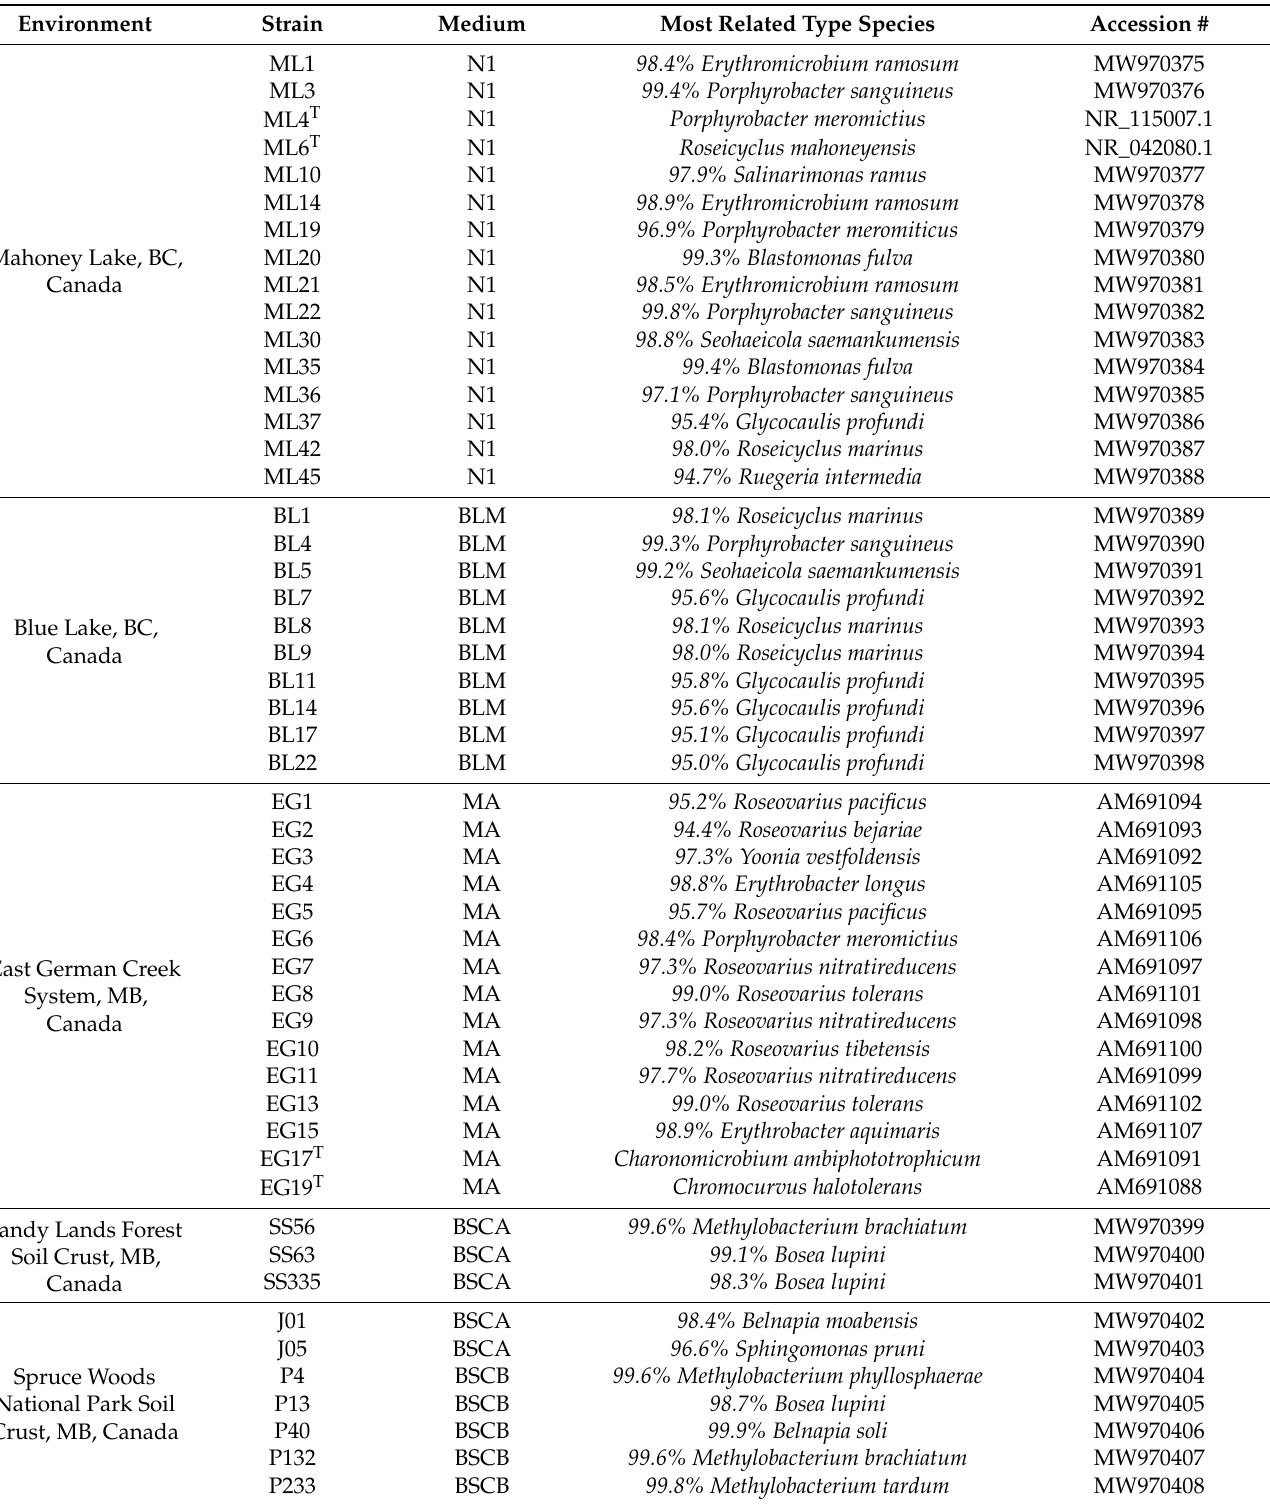
Table A2. Meromictic lake and biological soil crust AAP chosen for siderophore